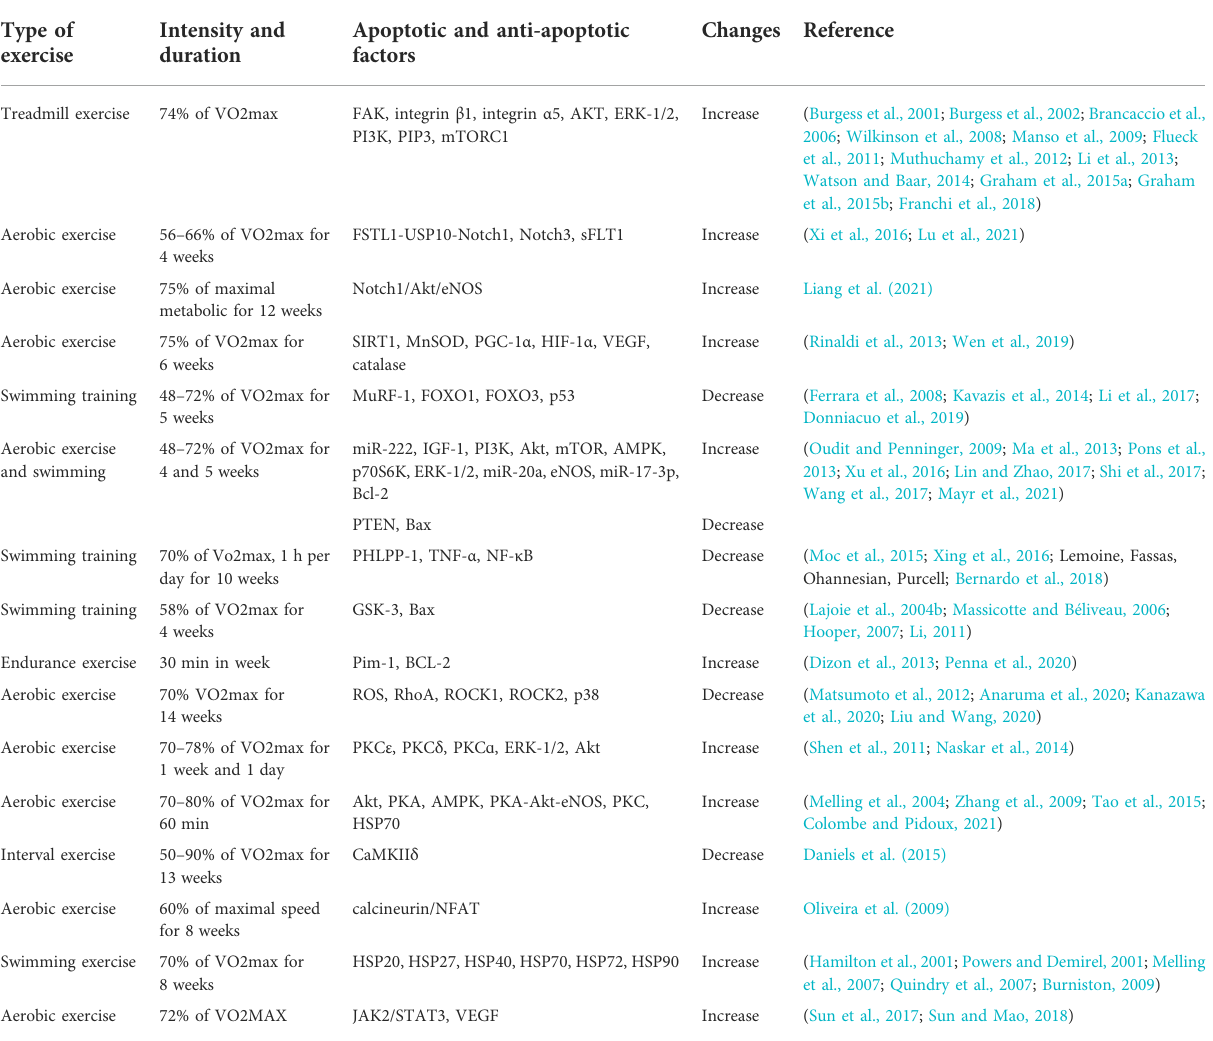
TABLE 2 A summary of exercise studies on the factors affecting cardiac